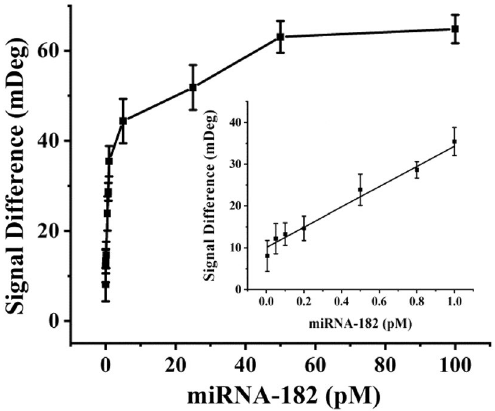
Figure 4. Dependence of the SPR signal difference on the concentrations of miRNA-182. The inset showed the linear portion of the curve with concentrations ranging from 0.005 to 1.0 pM. The error bars represented the standard deviations for three replicate measurements.